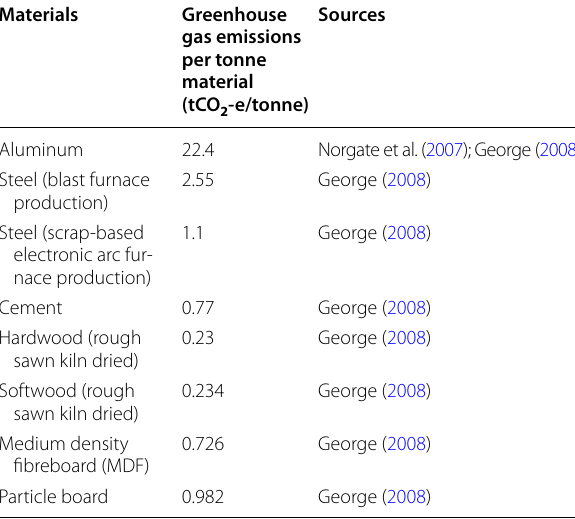
Table 1 Greenhouse gas emission profile of wood and key competitors. Adopted from George (2008)